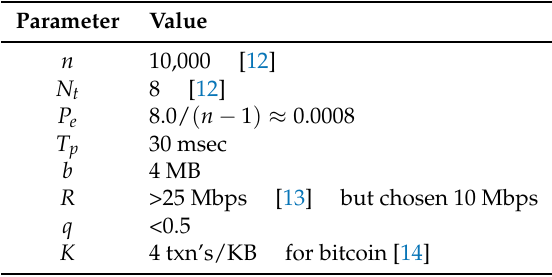
Table 2. Parameter values for the case of Bitcoin. Parameter